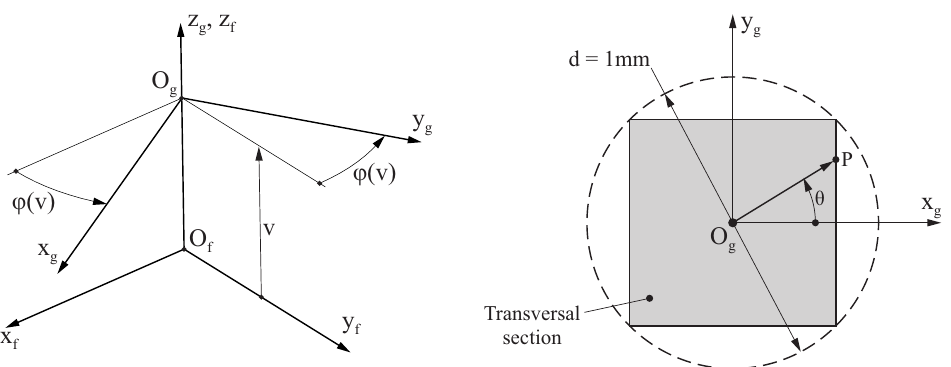
Figure 3. ( Left ) Definition of coordinate systems S f and S g and ( Right ) definition of a sample squared cross section for the endodontic